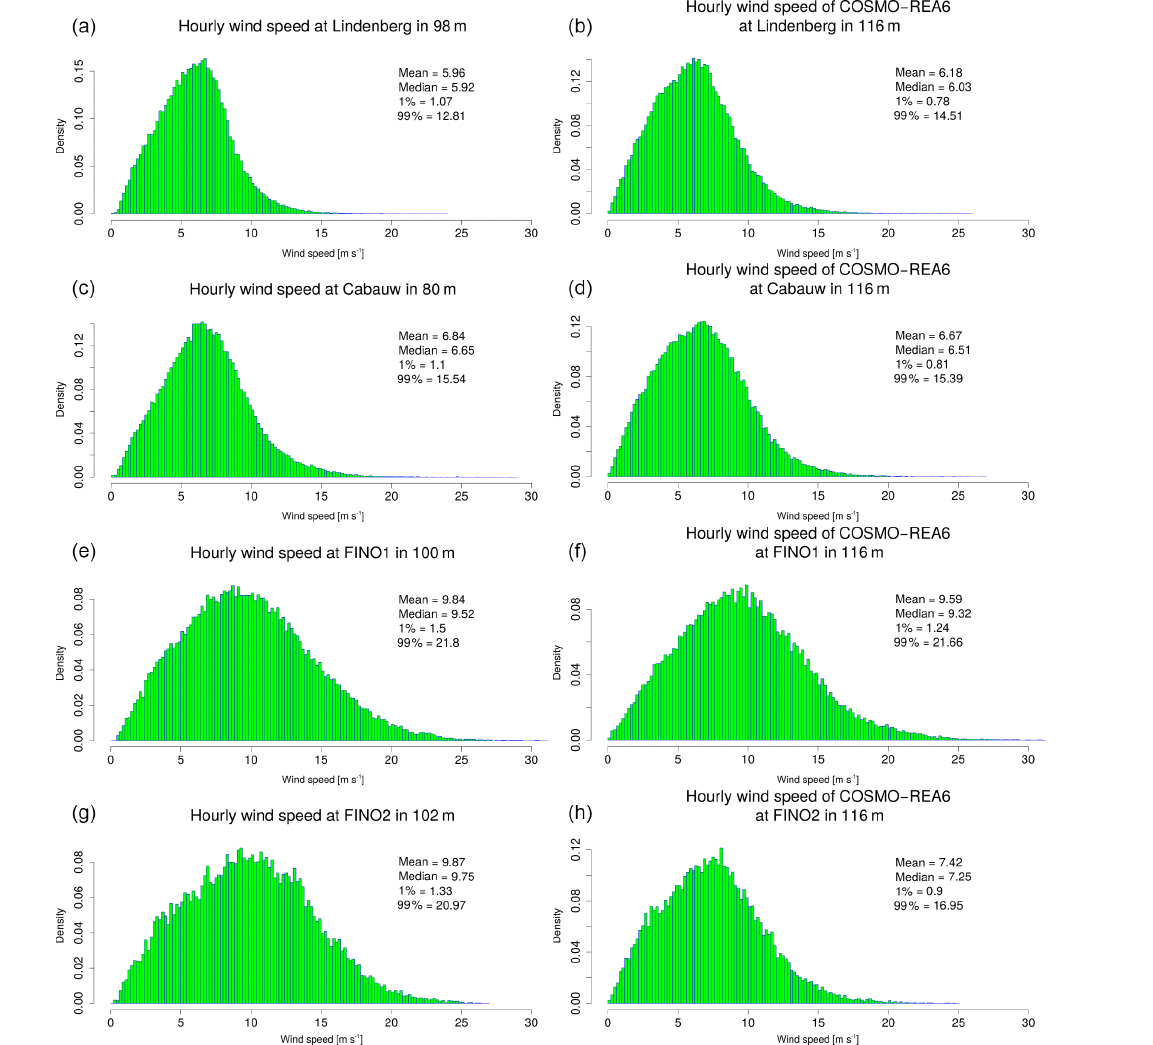
Figure 2. Histograms of the probability distributions of wind speed for Lindenberg, Cabauw, FINO1, and FINO2 measurements (left, from top to bottom, respectively) and the corresponding COSMO-REA6 histograms for the location of the measurements (right). Values on the right side of each panel describe the mean, median, 1% percentile, and 99% percentile for the corresponding histograms in ms − 1